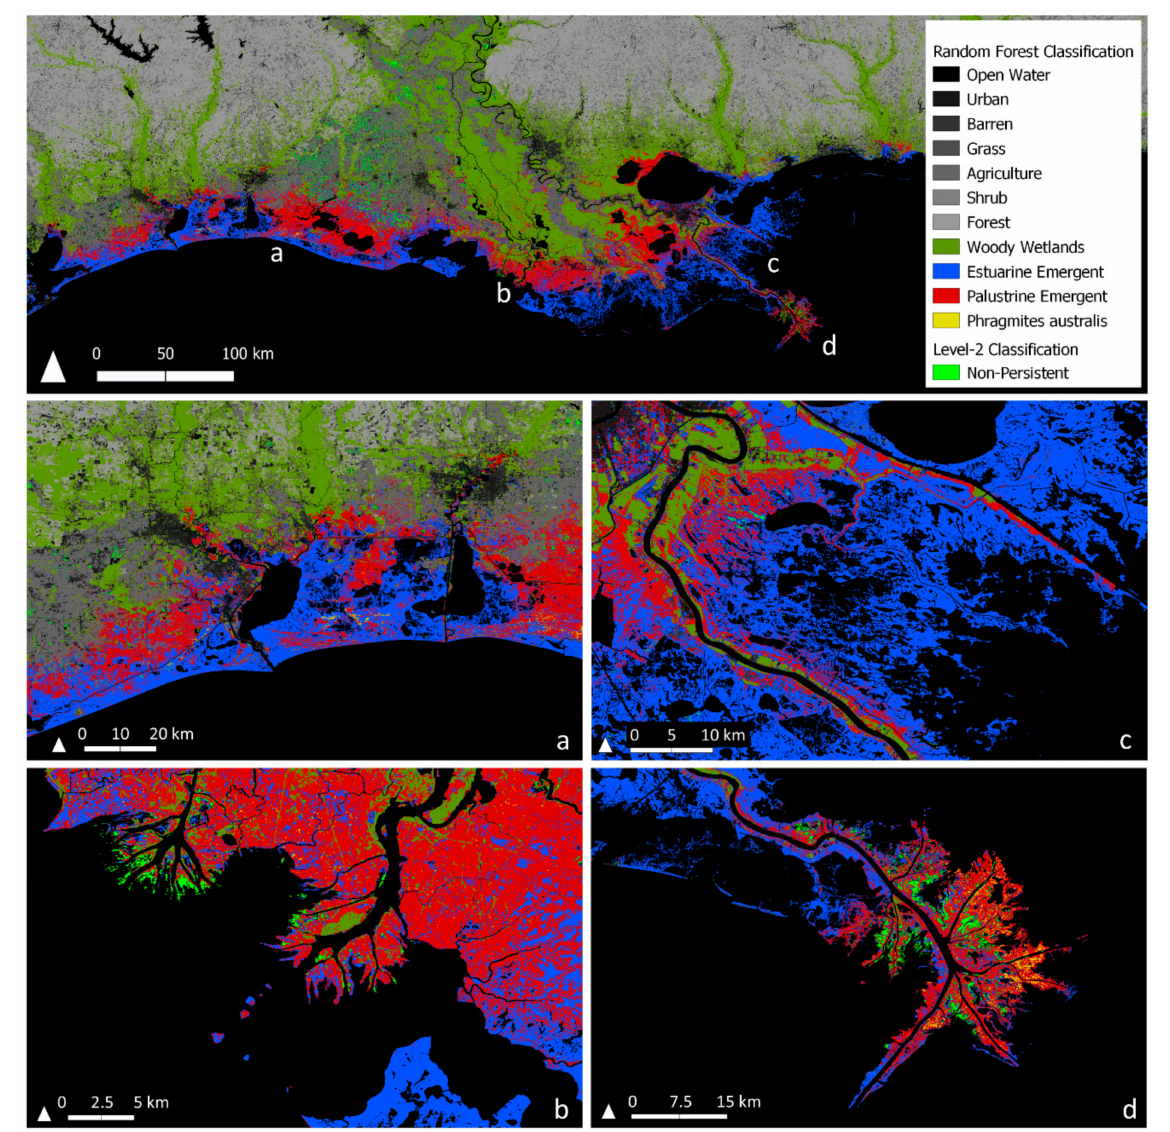
Figure 14. Maps of Gulf Coast level-2 classification, which use a decision tree classifier to modify the level-1 classification. Panels ( a – d ) correspond to the Sabine River, Wax Lake Delta (and surrounding wetlands), the Brenton Sound, and the Bird’s Foot Delta, respectively. Note that level-1 emergent wetland colors have been muted to highlight locations of non-persistent vegetation in the level-2